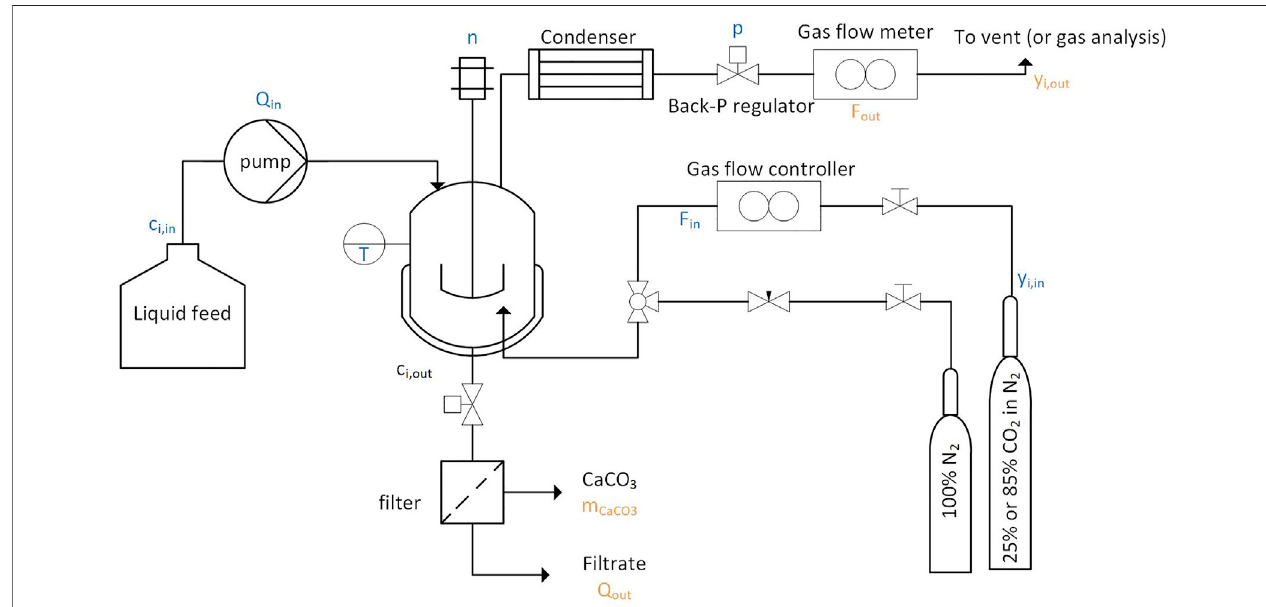
FIGURE1| Inthe simpli fi ed fl ow sheet,theletters inblue specifytheoperating andfeed conditions, while theorganletters specifythedownstreamdatameasured throughout the experiment.